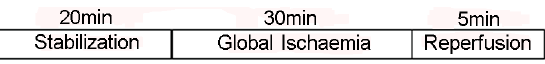
Figure 7. Study design showing perfusion protocol.